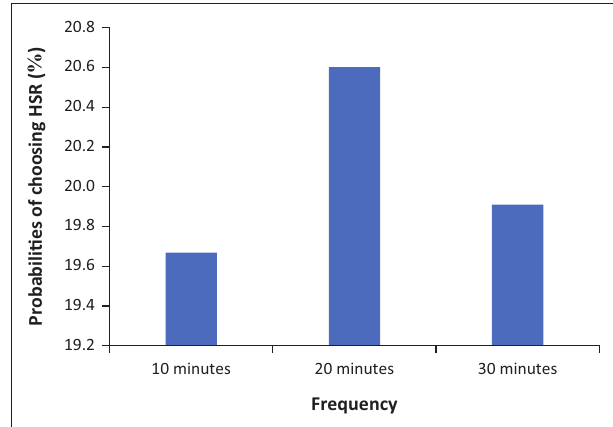
FIGURE 6: Probability of choosing high-speed rail based on frequency.